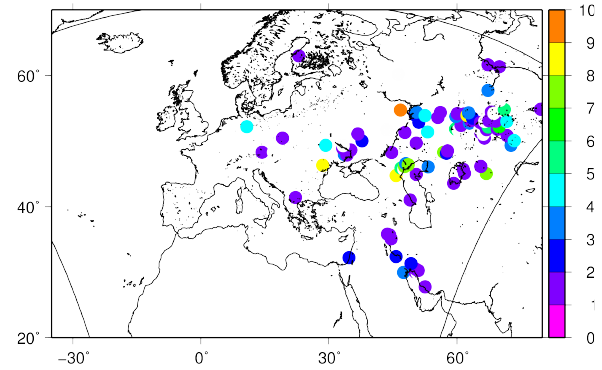
Fig. 11. Example of area burned (km 2 ) calculated using the fire emissions preprocessor for 8 May 2012 over western Europe.